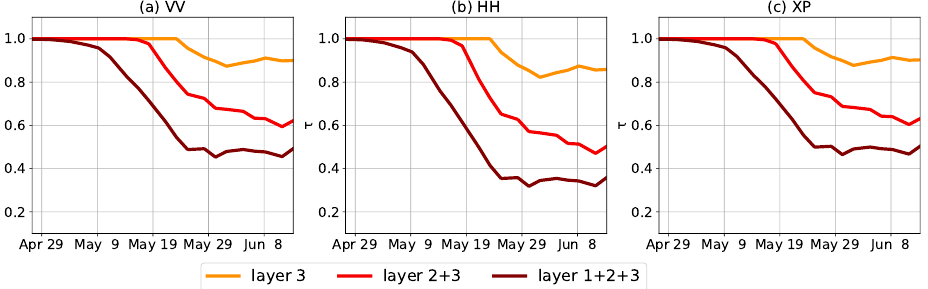
Figure 8. Seasonal variations in the transmissivity ( τ ) at different depths of the vegetation layer, simulated by the 3-layer water cloud model. The different polarizations are separated in: ( a ) VV; ( b ) HH; and ( c )